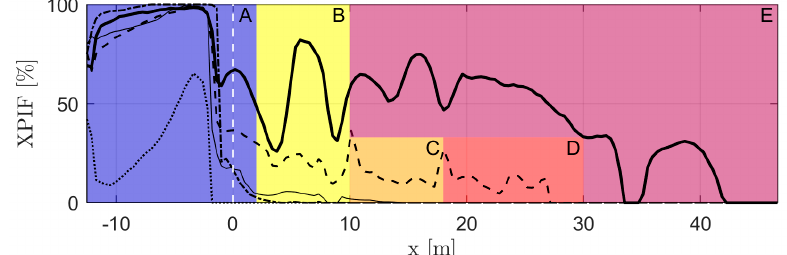
Figure 13. Five examples of XPIFs recorded at transect N2 under different conditions that meet the criteria for the five hazard categories (Table 2): Category A recorded on 22/03/2017 at 12:00 (dotted line), Category B recorded on 26/03/2017 at 16:00 (dash-dot line), Category C recorded on 26/03/2017 at 11:00 (thin solid line), Category D recorded on 23/03/2017 at 12:00 (dashed line), and Category E recorded on 04/04/2017 at 17:00 (thick solid line). The shaded areas represent the five hazard categories defined for transect N2: Category A (blue), Category B (yellow), Category C (orange), Category D (red), and Category E (purple). A profile line terminates (i.e., XPIF goes to 0) in the shaded area of the hazard category to which it belongs, e.g., the dashed line (representing an example XPIF profile for Category D) terminates in the red shaded area at x ~27 m. The white dashed line represents the edge of the platform at x = 0 m. See Section 5.3 and Table 2 for additional detail on the hazard categories.